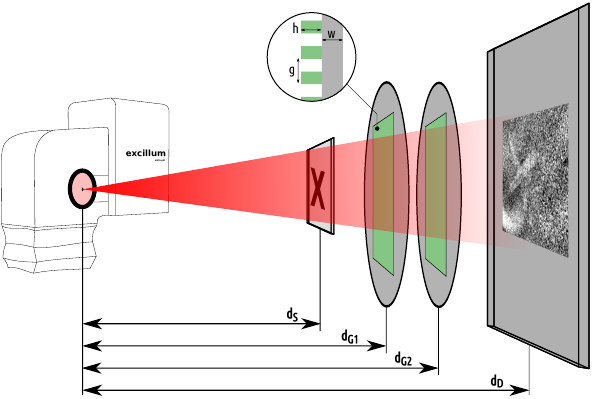
Figure 1. Sketch of the imaging setup showing the Excillum C2 metal-jet X-ray source head on the left, operated at a power of 58W and 55 µ m spot size. The cone beam is depicted by the red rectangle with an intensity gradient. The paper sample is situated at a distance of d S = 90cm from the source, followed by the phase grating G1 and the analyser grating G2 at the distances d G1 = 100cm and d G2 = 120cm, respectively. Placed at d D = 138cm is the X-ray detector with 49.5 µ m pixel size. The zoom-in shows the grating structure with the grating pitch g , the grating bar height h and the wafer thickness w